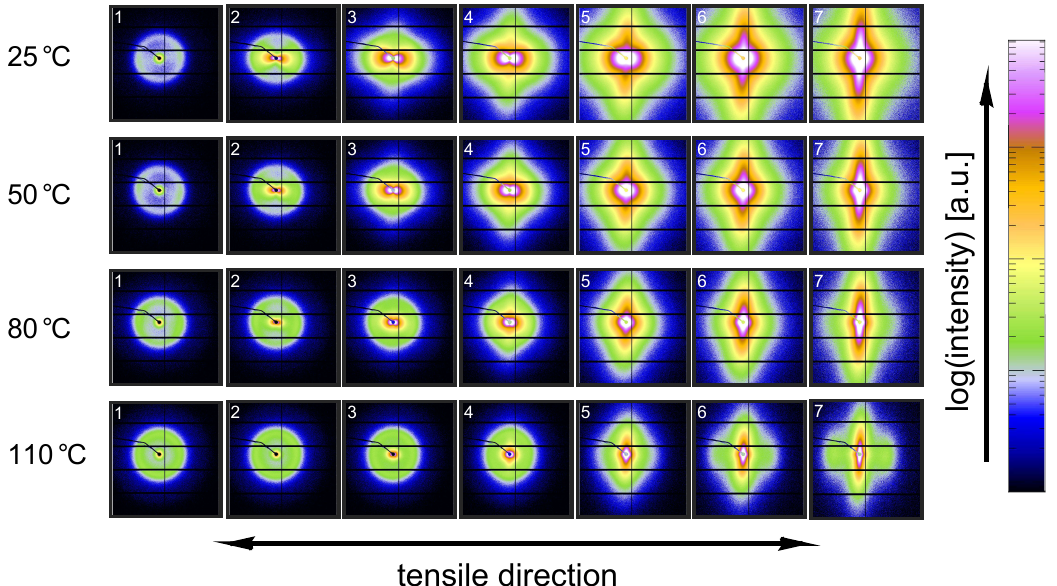
Figure 23. Normalized 2D SAXS patterns of β -iPP stretched at temperatures of 25, 50, 80 and 110 ◦ C from top to bottom. The true strains, determined with the assumption of fully uni-axial deformation, are given as well. The macroscopic strains at which the patterns were taken are indicated by the markers in Figure 8. The stretching direction is